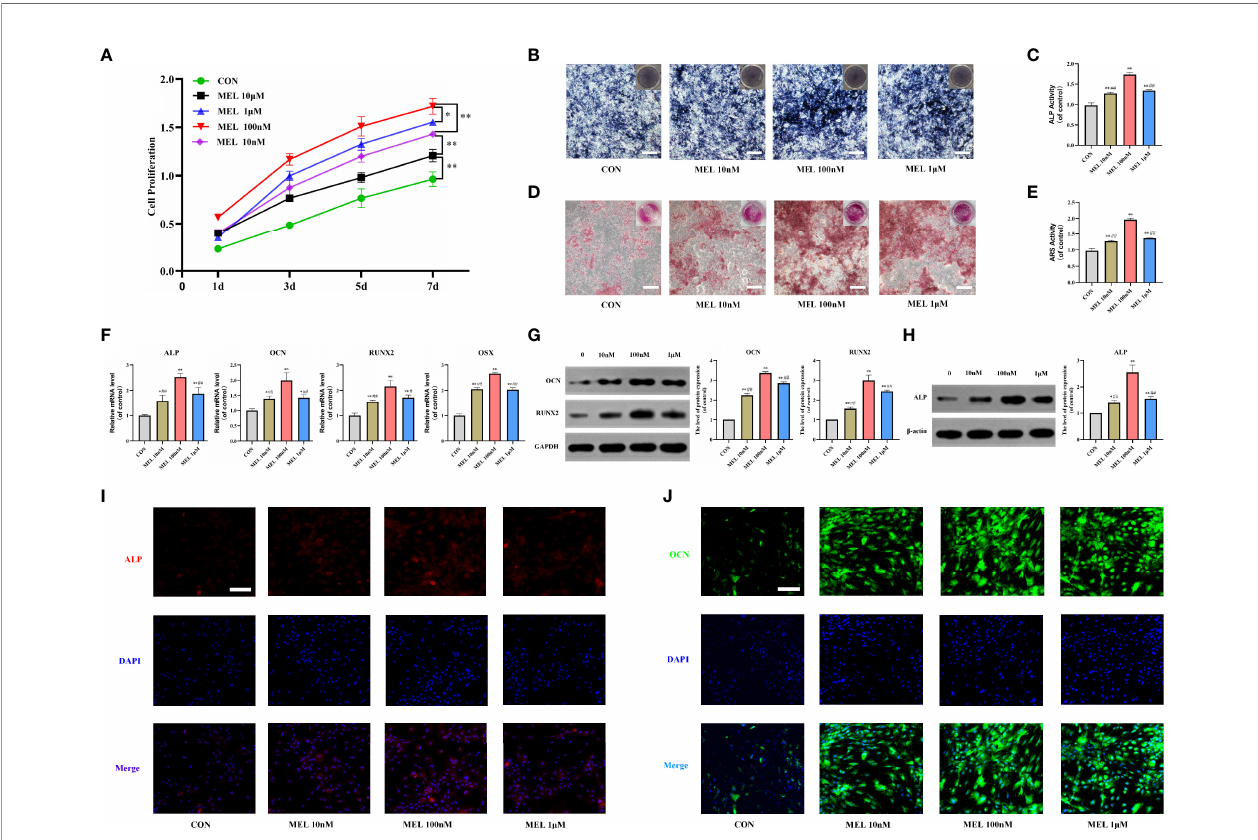
FIGURE 1 | Melatonin promoted the osteogenesis of BMSCs in vitro . (A) The effect of melatonin on BMSC proliferation measured by CCK-8 assays. (B, C) Images and quanti fi cation of ALP activity after 7 days of osteogenic induction (scale bars, 200 m m). (D, E) Calcium mineralization was assessed via ARS staining and quanti fi cation (scale bars, 200 m m). (F) mRNA expression levels of osteogenesis-related markers in BMSCs following treatment with/without melatonin. (G, H) Protein expression levels of osteogenesis-related markers (OCN, RUNX2, and ALP). (I, J) Immuno fl uorescent images of BMSCs stained for ALP and OCN (scale bars, 100 m m). All the experiments were repeated at least 3 times independently. CCK-8, cell counting kit-8; BMSCs, bone marrow mesenchymal stem cells; ARS, alizarin red S; ALP, alkaline phosphatase; OCN, osteocalcin; RUNX2, runt-related transcription factor 2. The data are presented as means ± SEM. * p < 0.05, ** p < 0.01 vs . control group, # p < 0.05, ## p < 0.01 vs . 100 nM melatonin